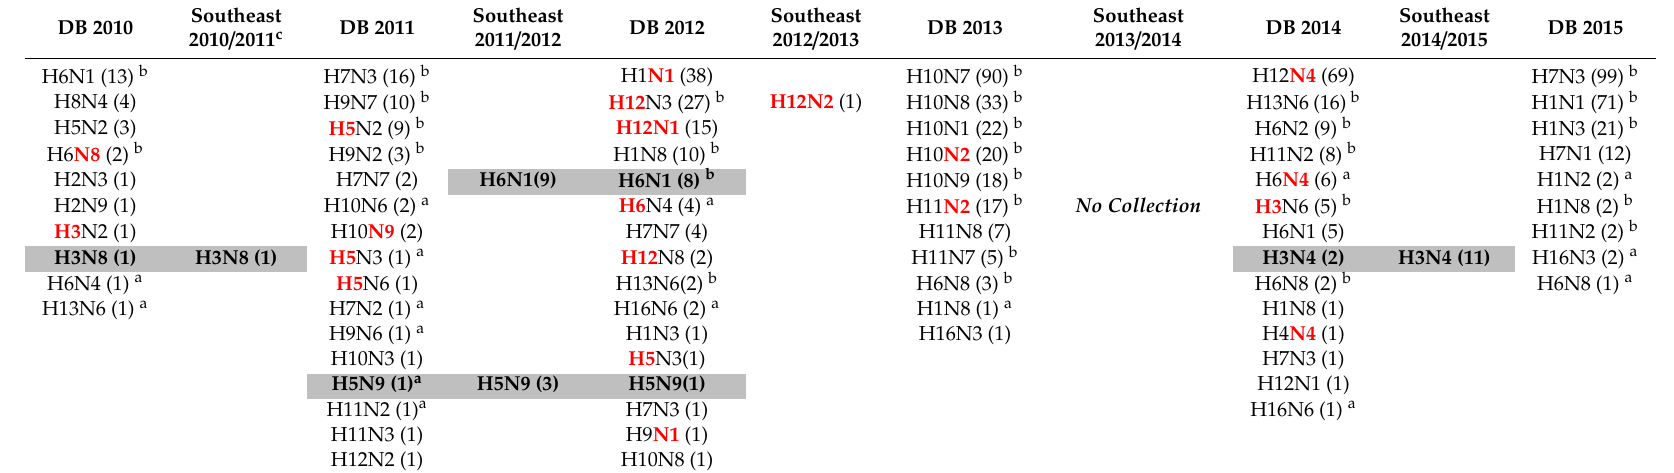
Table 2. Number of influenza A viruses, by subtype (number), isolated from shorebird samples collected at Delaware Bay (DB) by St. Jude Children’s Research Hospital (SJCRH, fecal samples) or at DB and southeastern U.S. sites by the University of Georgia (UGA, fecal or oropharyngeal and cloacal (OP / CL) swabs) from ruddy turnstones, by year. Collections are indicated in chronological order, from May 2010 (DB) through May 2015 (DB). HA or NA subtypes colored red were seen in a preceding or subsequent sampling e ff ort, also designated by a red arrow along the top of the table. Cells shaded gray indicate the recovery of a matched HA and NA subtype in a preceding and / or subsequent collection.